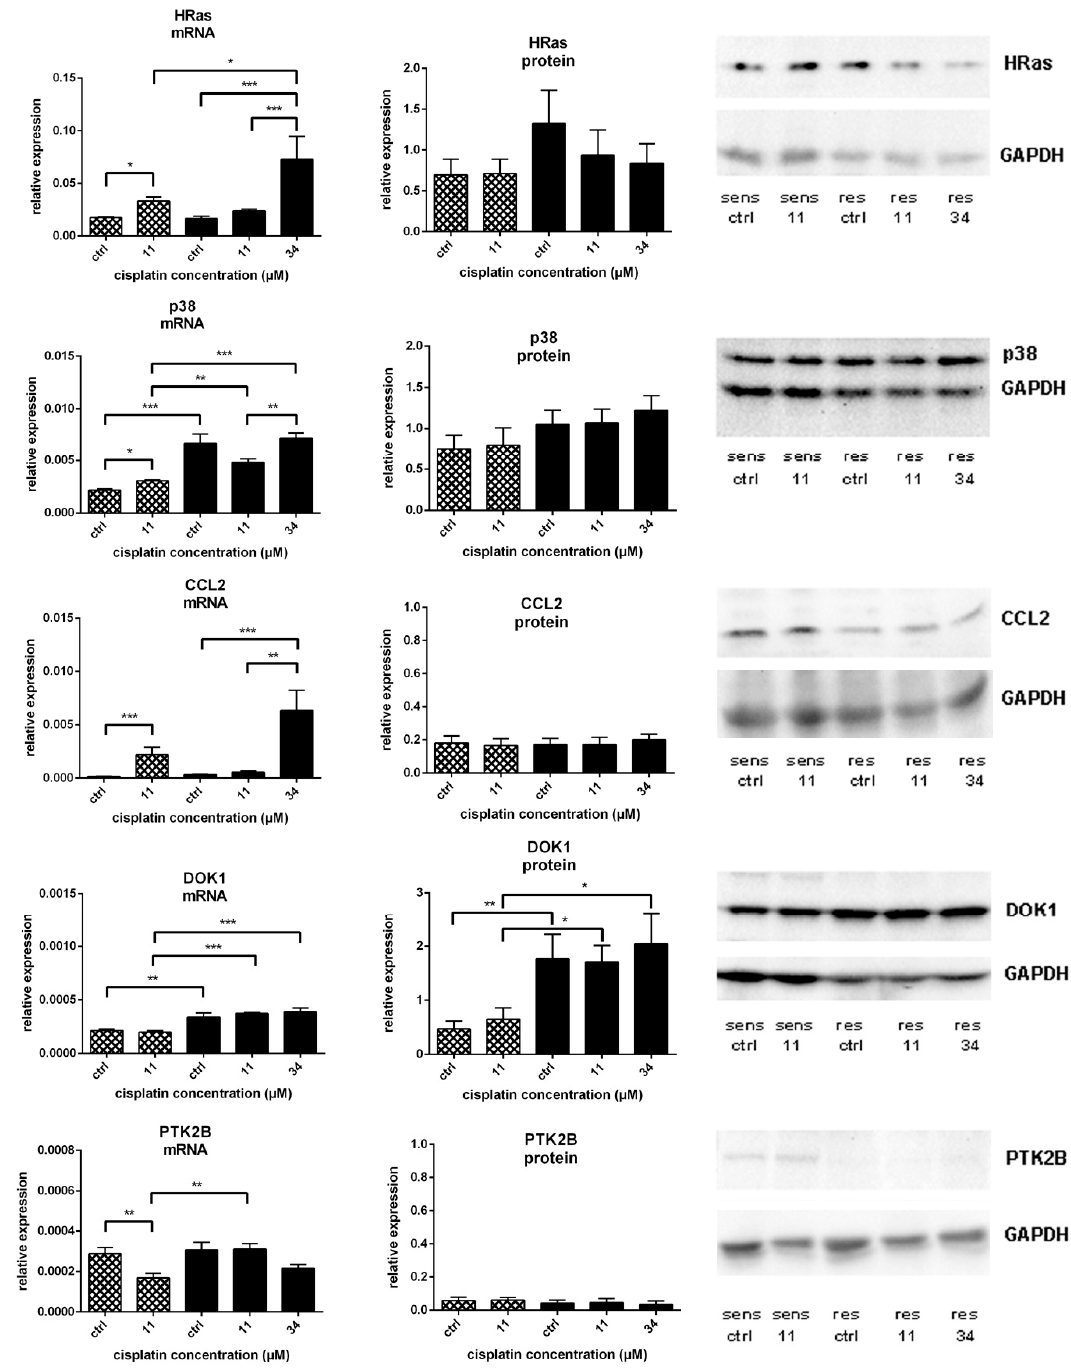
Figure 4. mRNA expression (all n = 6) of HRas , MAPK14 (p38), CCL2 , DOK1 and PTK2B related to GAPDH mRNA expression; protein expression of HRas ( n = 6), p38 ( n = 6), CCL2 ( n = 4), DOK1 ( n = 7–8) and PTK2B ( n = 3) related to GAPDH expression in A549 ( ) and A549 r CDDP 2000 ( ) before (ctrl) and after treatment with 11 µM cisplatin (11) or 34 µM cisplatin (34) presented as mean ± SEM; as well as representative Western blots. * p < 0.05; ** p < 0.01; *** p < 0.01.